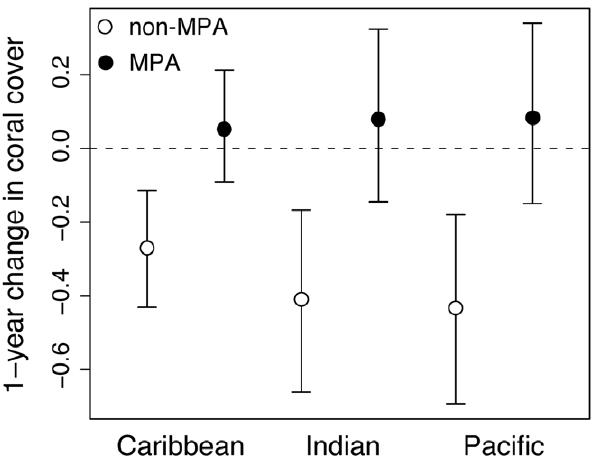
Figure 3. The change in percent coral cover from 2004 to 2005 inside and outside of MPAs. The 95% credibility intervals (error bars) are also shown. Reefs protected in MPAs had slightly positive changes in percent coral cover, although not significantly different from zero (dashed line). Percent coral cover was obtained by back-transforming the predicted logit from the